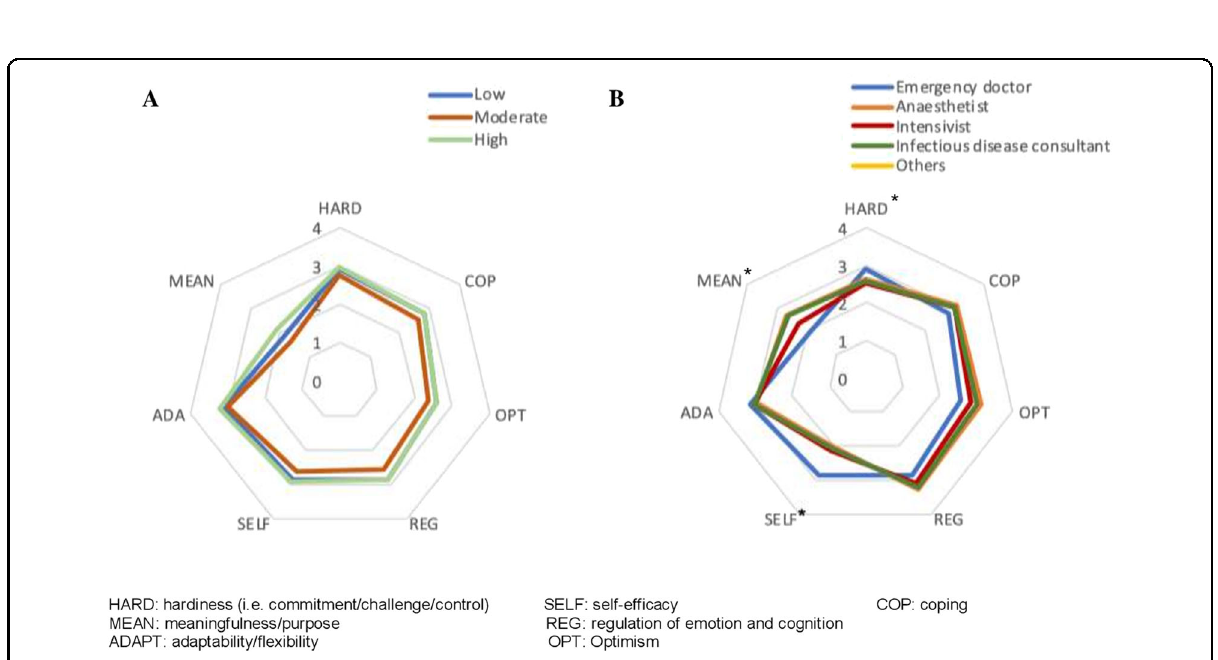
Fig. 2 Average score of the seven components of the resilience score according to physicians ’ characteristics. A Low, moderate, and high level of caseload. B Physician